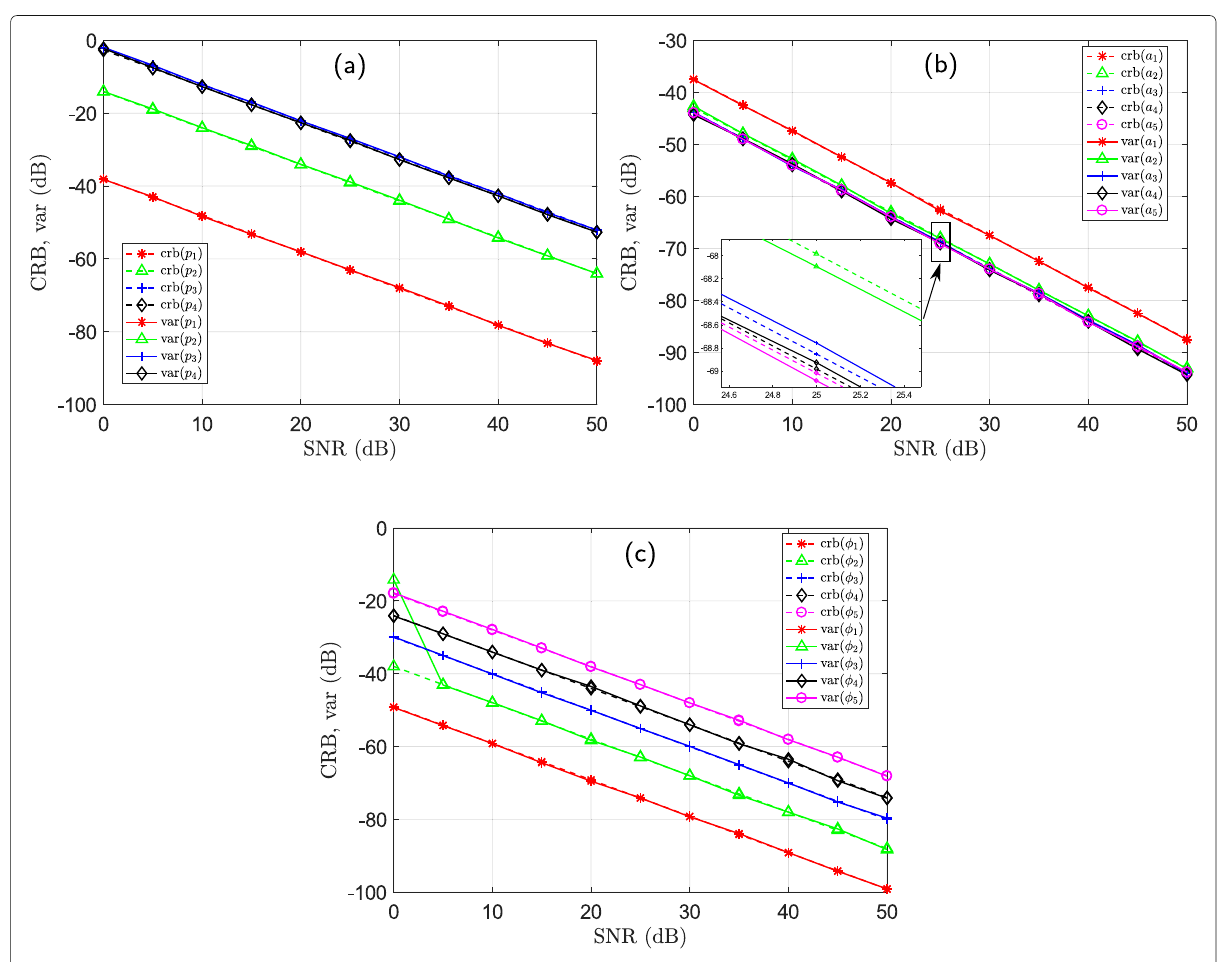
Fig. 7 Comparison of the CRB and estimated parameters’ variance. Represented is the CRB vs. variance for p ( a ), a ( b ), and φ ( c ). The CRB curves are represented using dashed lines and the variance curves using solid lines. We used 1000 Monte-Carlo